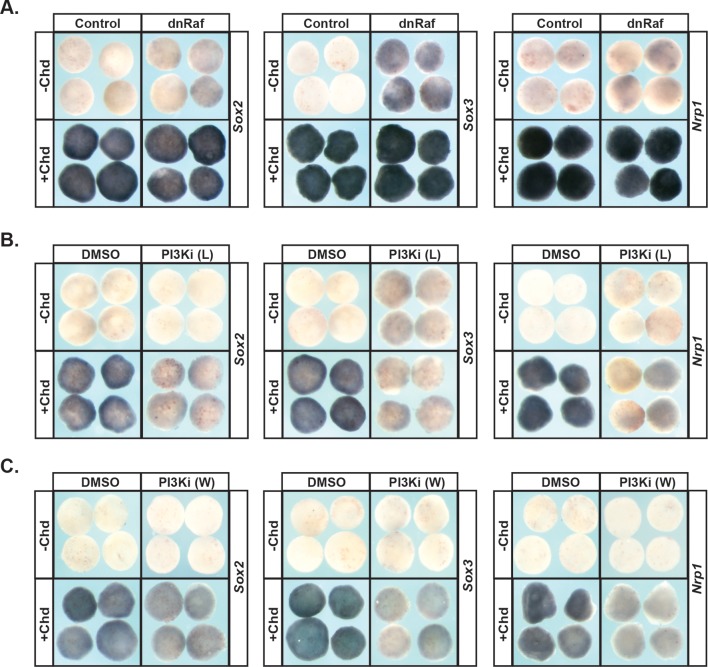
Blocking PI3K/Akt activation using PI3Ki (L) (LY294) or PI3Ki (W) (Wortmannin) phenocopies the effects of dnPI3K on Chordin-mediated neural induction.(A–C) Animal pole explant assay examining Sox2, Sox3, and Nrp1 expression in Chordin (Chd) induced animal cap explants injected with dnRaf (A) or treated with PI3Ki (L) (B) or PI3Ki (W) (C). Explants were cultured alongside sibling embryos and collected at early neurula stages (stage 13) for Sox2/3 or late neurula stages (stage 18) for Nrp1. PI3Ki (L) and PI3Ki (W) phenocopy the effects of dnPI3K on Chordin-mediated neural induction.